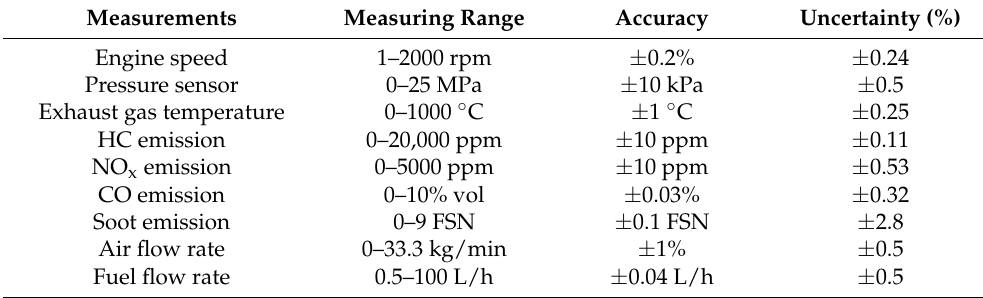
Table 4. Uncertainty of measured parameters.